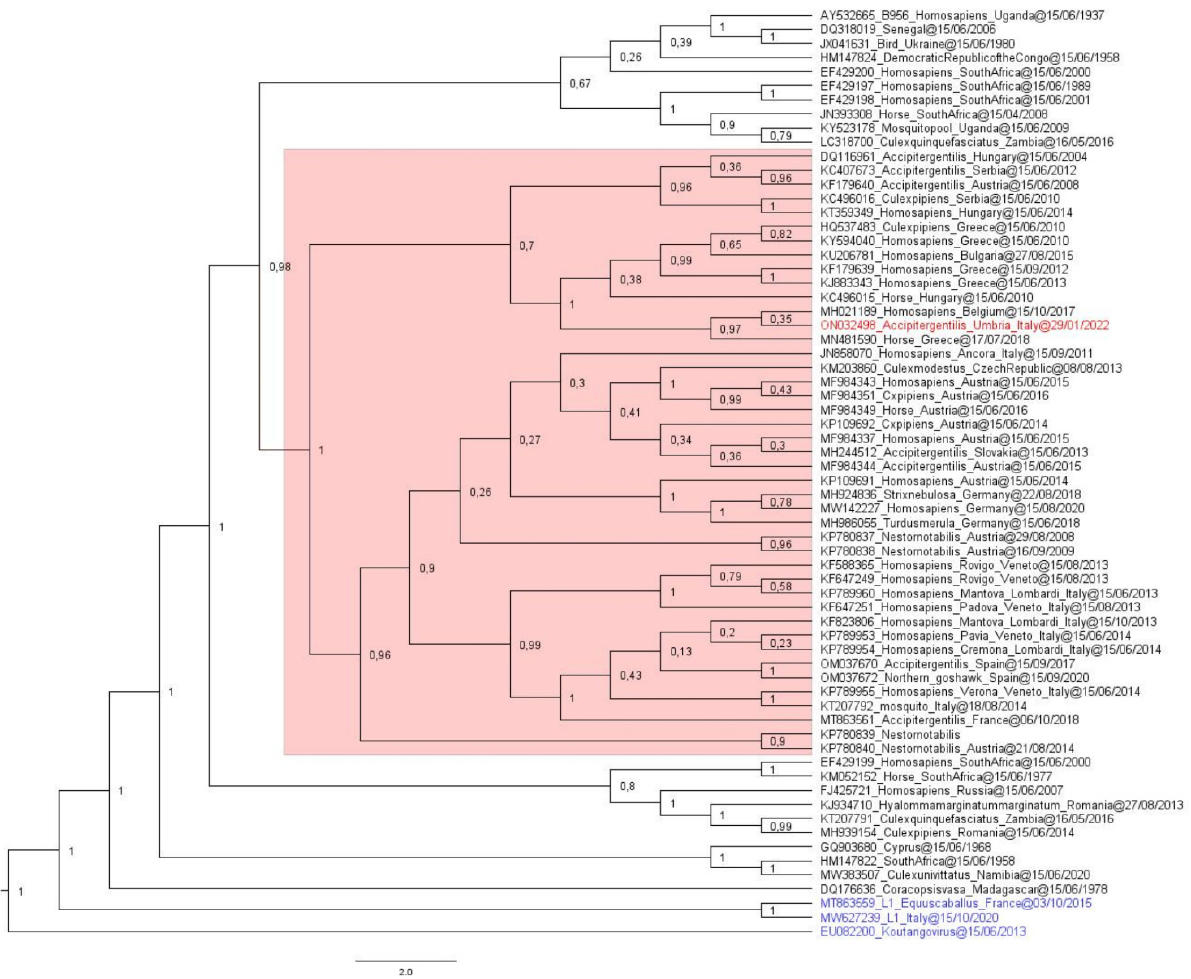
the FigTree v2.6.3 program (http://tree.bio.ed.ac.uk/software/) allowed the estimation of a